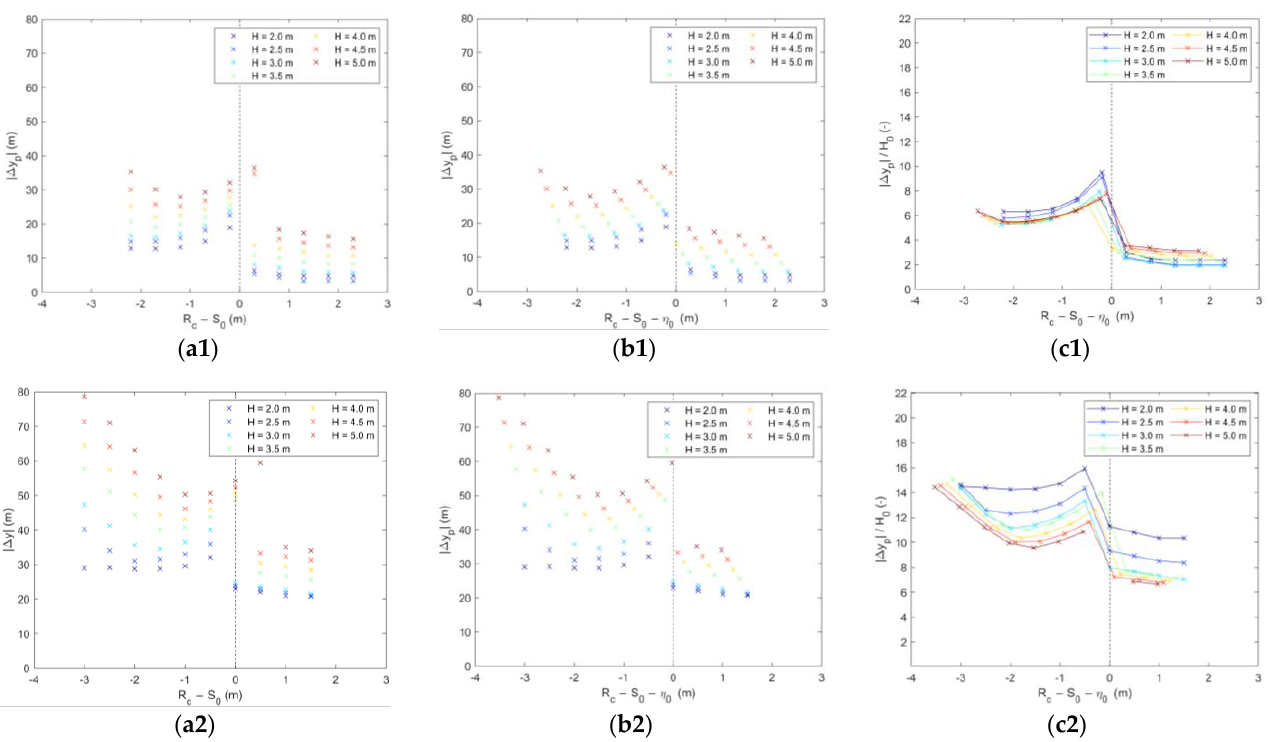
Figure 8. Absolute (| Δ y p | ) and relative shoreline recession (| Δ y p |/H 0 ) for beaches protected by breakwaters for 2 different values of sea level rise: ( a1 ), ( b1 ) and ( c1 ) for S 0 = 0.2 m; ( a2 ), ( b2 ) and ( c2 ) for S 0 = 1.0 m. ( a1 ), ( a2 ) absolute recession with respect to R c − S 0 ; ( b1 ), ( b2 ) absolute recession with respect to R c − S 0 − 𝜂̅ 0 ; c1, c2 relative recession with respect to R c − S 0 − 𝜂̅ 0 . Constant values: B = 8 m, h t = 3 m, T = 9 s, m = 1/20.